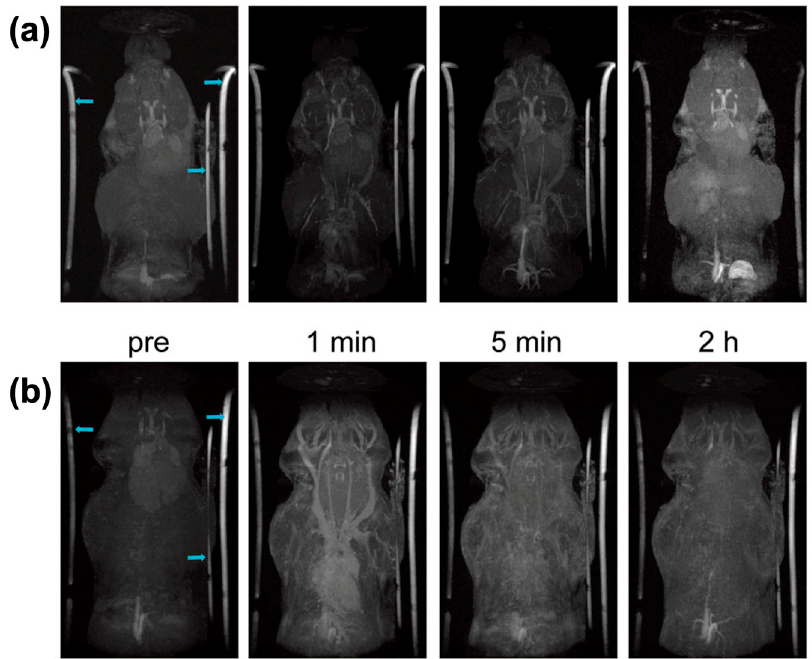
Figure 3. Magnetic resonance angiography of head and neck in mice injected with MFt and Gd-DTPA: ( a ) After injecting MFt, MFt provided continuous contrast enhancements within 2 hours; ( b ) after Gd-DTPA administered, short term blood pool imaging was observed compared with MFt. Reprinted with permission from Ref 47 Copyright 2019 Royal Society of Chemistry.